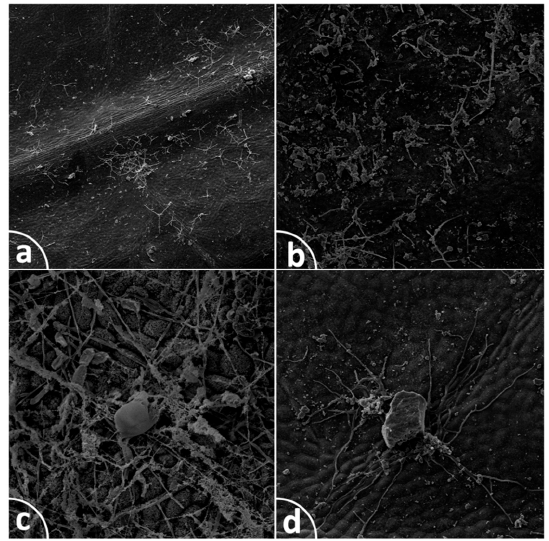
Figure 2. Images of the common oak leaf surface obtained by the scanning electron microscope (SEM): ( a ) a fragment of the leaf surface with the mycelium (Hyphae), the leaf sampled in May, magnification × 50; ( b ) the net of oak powdery mildew mycelium with retained pollution, magnification × 150; ( c ) conidia of oak powdery mildew with retained pollution, magnification × 350; and ( d ) particulate matter, magnification × 200. Water 2018 , 10 , x FOR PEER REVIEW